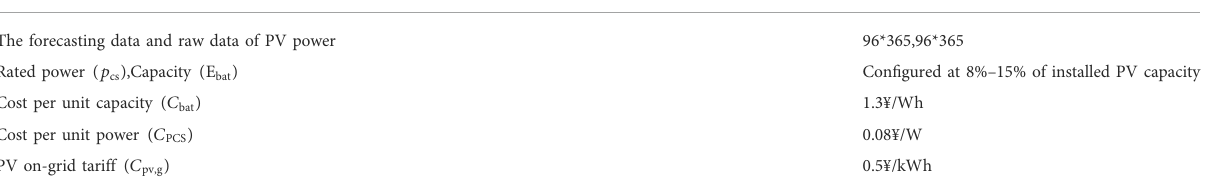
TABLE 2 Main parameter settings. Parameter